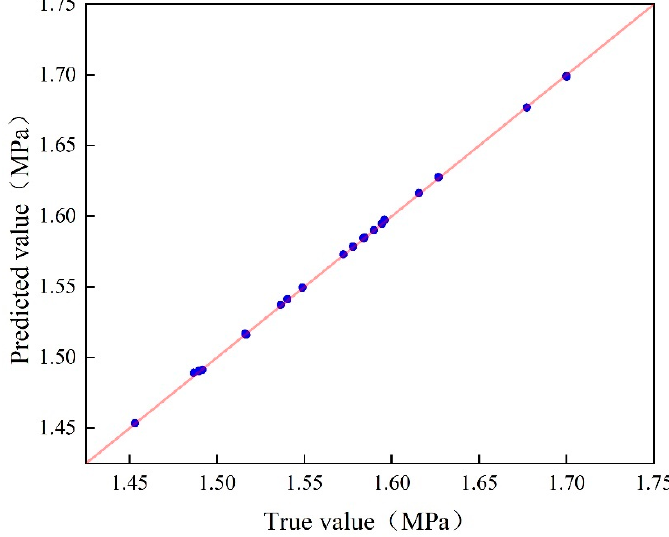
Figure 9. Comparison between the predicted and true value of P min .